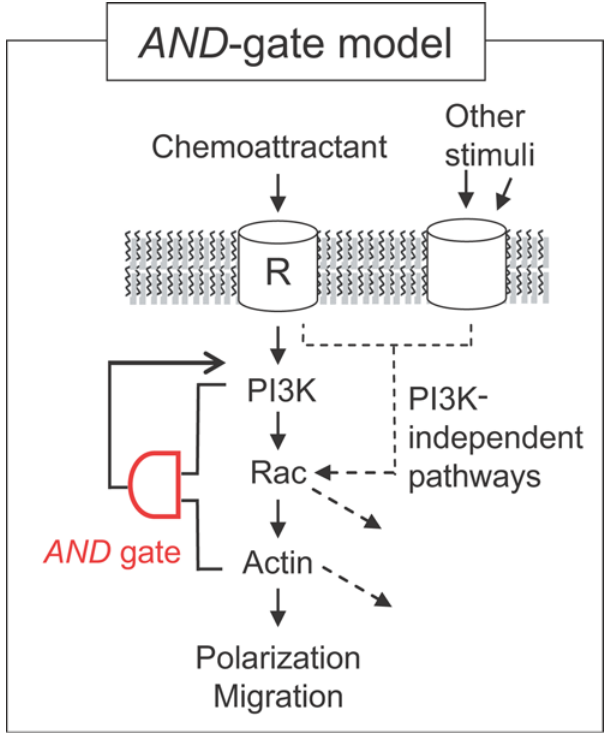
Figure 8. AND-gate model for PI3K-triggered cell polarization and migration. Coincidence detection model in which an AND-gate switch has to be triggered for cell polarization and migration. The requirement of the AND-gate for triggering PI3K-mediated polarization, may allow Rac, a common effector shared in different signaling pathways, to perform multiple functions including a role in PI3K- dependent and possibly in PI3K-independent cell polarization. Scale bars, 10 m